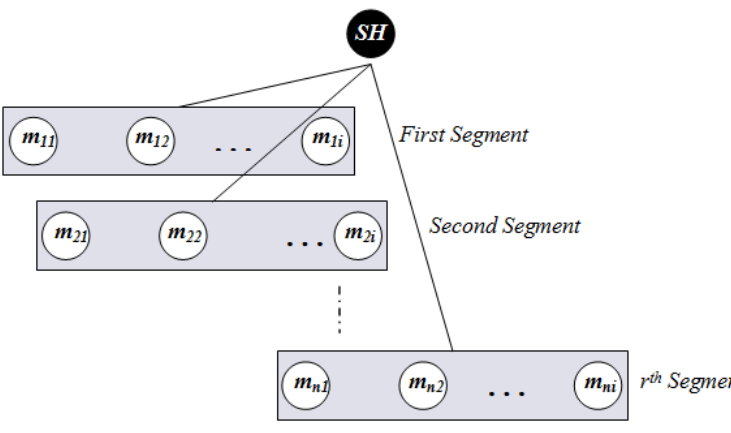
Figure 6. Formation of balls or segments inside a sector.